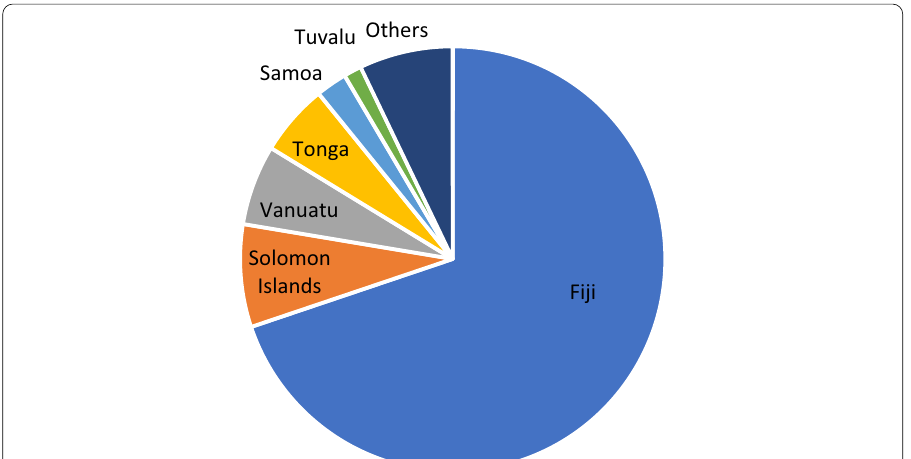
Fig. 2 Breakdown of the survey respondents by their country of residence